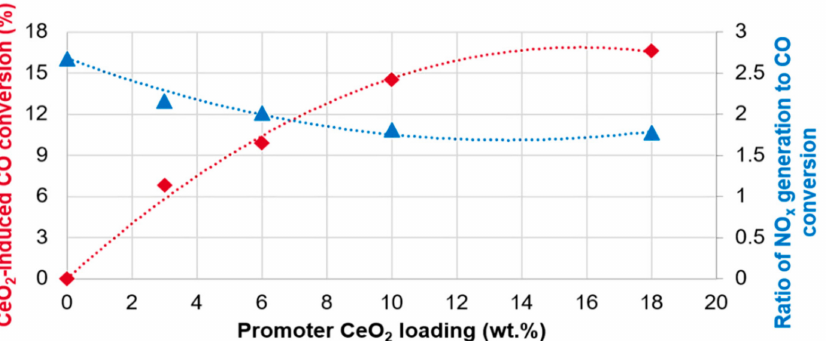
Figure 3. The CeO 2 -induced CO conversion as well as the ratio of NO x generation to CO con- version are reported as a function of promoter CeO 2 content. The lines are intended for trend visualization purposes only. Catalysts were tested by mixing 99% spent FCC catalyst and 1% fresh promoter using a plug flow reactor operating at 1 L/min flow rate with a feed of 2 vol.% O 2 in N 2 at 700 ◦ C. The emissions values determined by comparing to a promoter-free base case experiment. The method used to calculate CO conversion and NO x generation is reported in the experimental section. The color-coding is reported in the